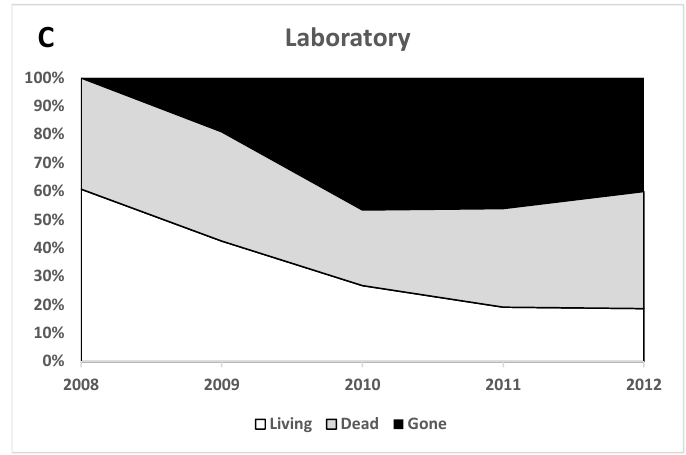
Figure 2. The average disappearance of cysts over time in the different environments during the first 4 years. The black area denotes disappeared cysts, gray represents dead and empty cysts, and white denotes filled live-appearing cysts. ( A ) oxygenized, ( B ) anoxic, and ( C ) laboratory (refrigerated) environments.